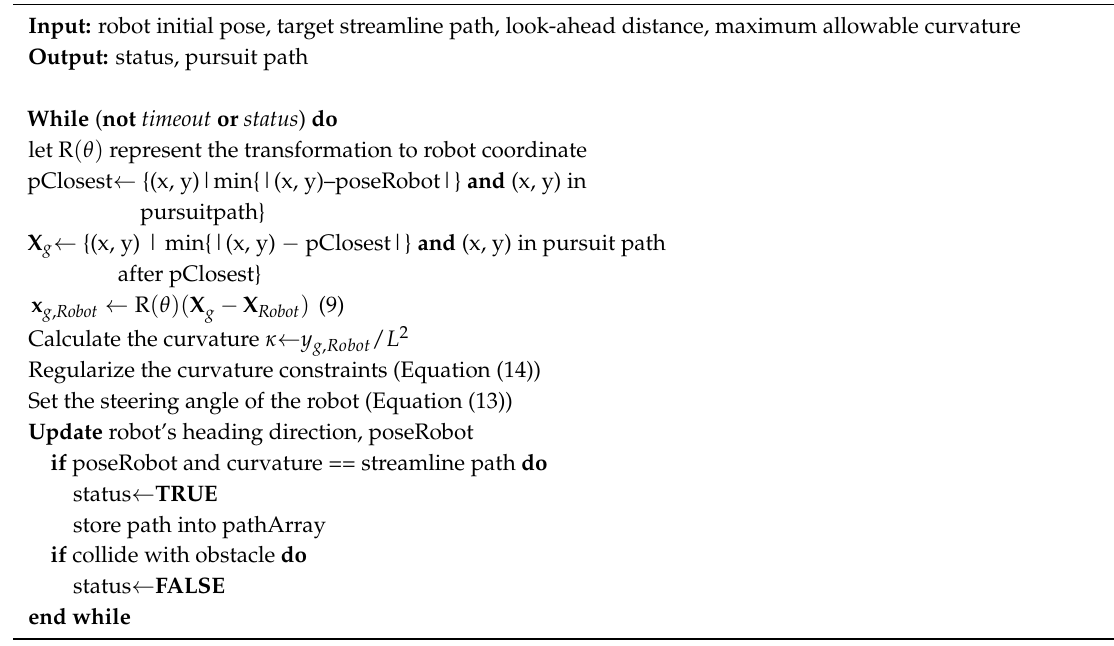
Algorithm 2. The pure pursuit streamline